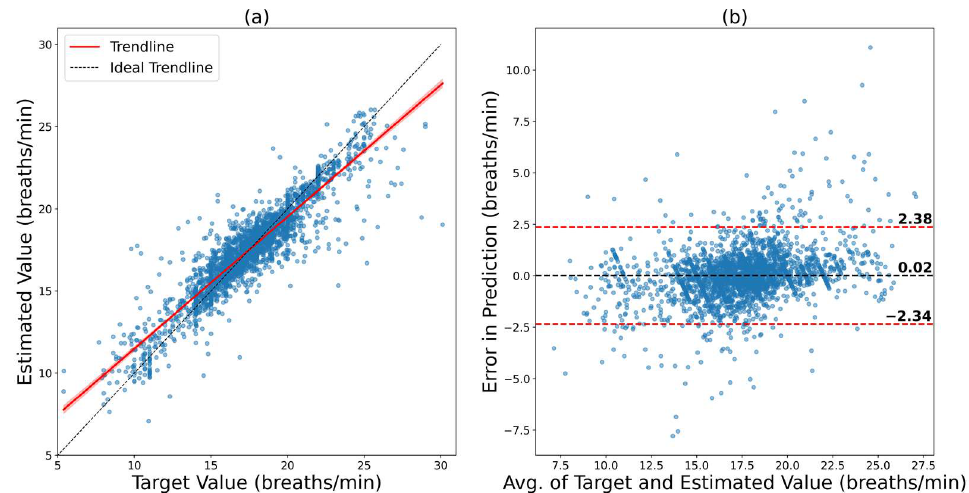
Figure 4. Results of ConvMixer on the BIDMC dataset. ( a ) Regression plot that shows how close the trendline is to the ideal trendline. ( b ) Bland–Altman plot that shows the 95% confidence interval of the error.